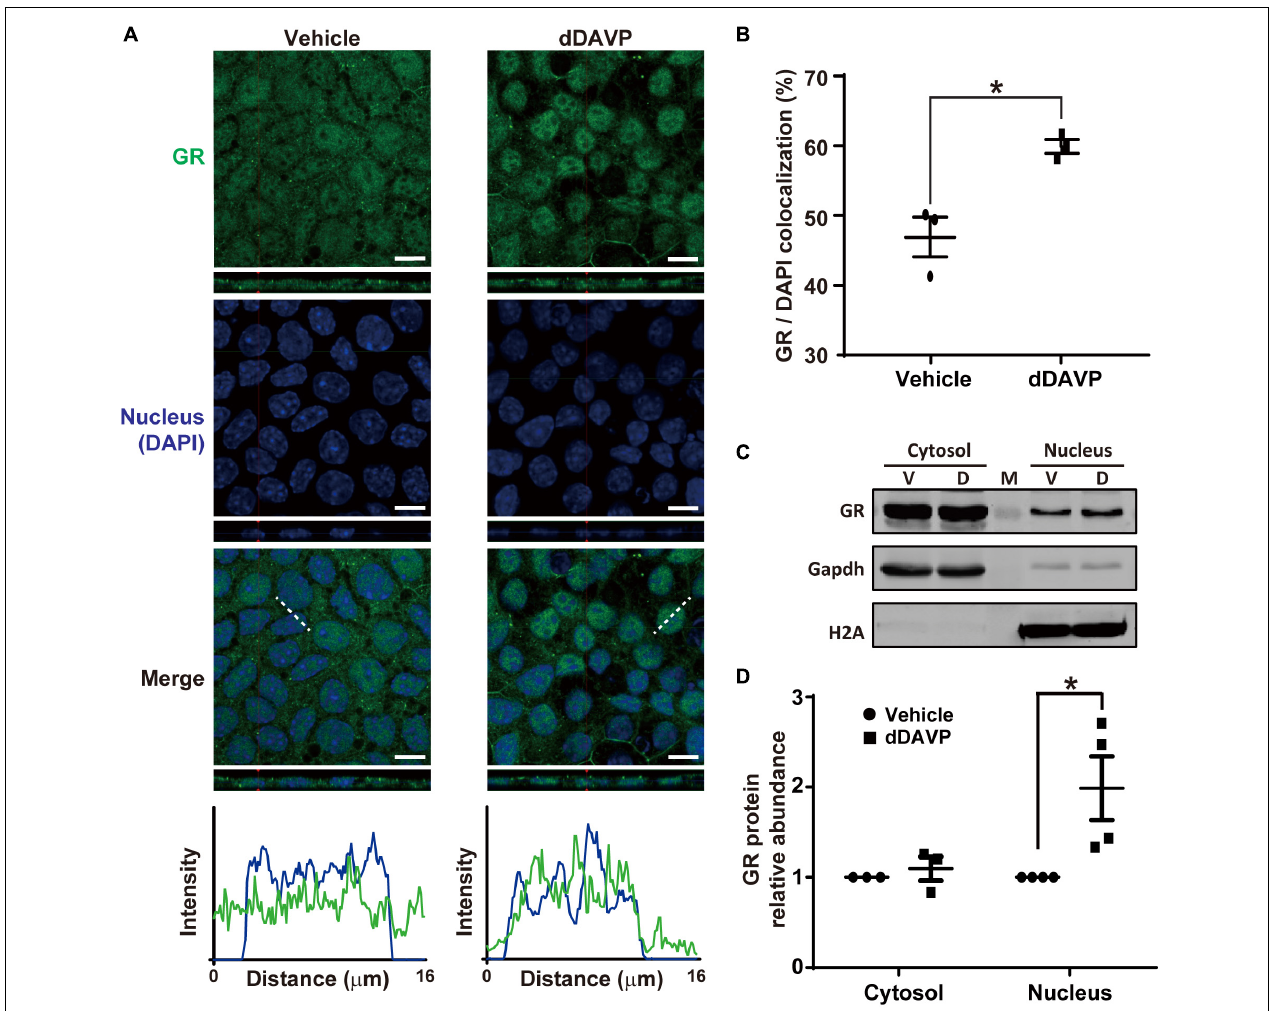
FIGURE 4 | Vasopressin induced glucocorticoid receptor nuclear translocation in the mpkCCD cells in the presence of dexamethasone. (A) Confocal immunofluorescence micrographs of glucocorticoid receptor (GR, green) and nuclei (DAPI, blue). Polarized cells grown on Transwell R (cid:13) were exposed (24 h) to vehicle, or 1 nM dDAVP. Shown at the bottoms are signal profiles along the dotted lines. Bars indicate 10 µ m. (B) Summaries of GR colocalization with DAPI. Numbers are means ± SEM, summarized from three independent experiments and about 330 cells per experiment. Asterisk indicates statistical significance, t -test p < 0.05. (C,D) Representative immunoblots and summary of GR in the cytosol vs. nuclei of the cells exposed to vehicle (V) vs. dDAVP (D). Numbers are means ± SEM, summarized from three or four independent experiments. Gapdh and H2A were markers for cytosol and nucleus, respectively. Protein intensities were corrected against those of Gapdh or H2A to avoid variations in the sample preparation. M,